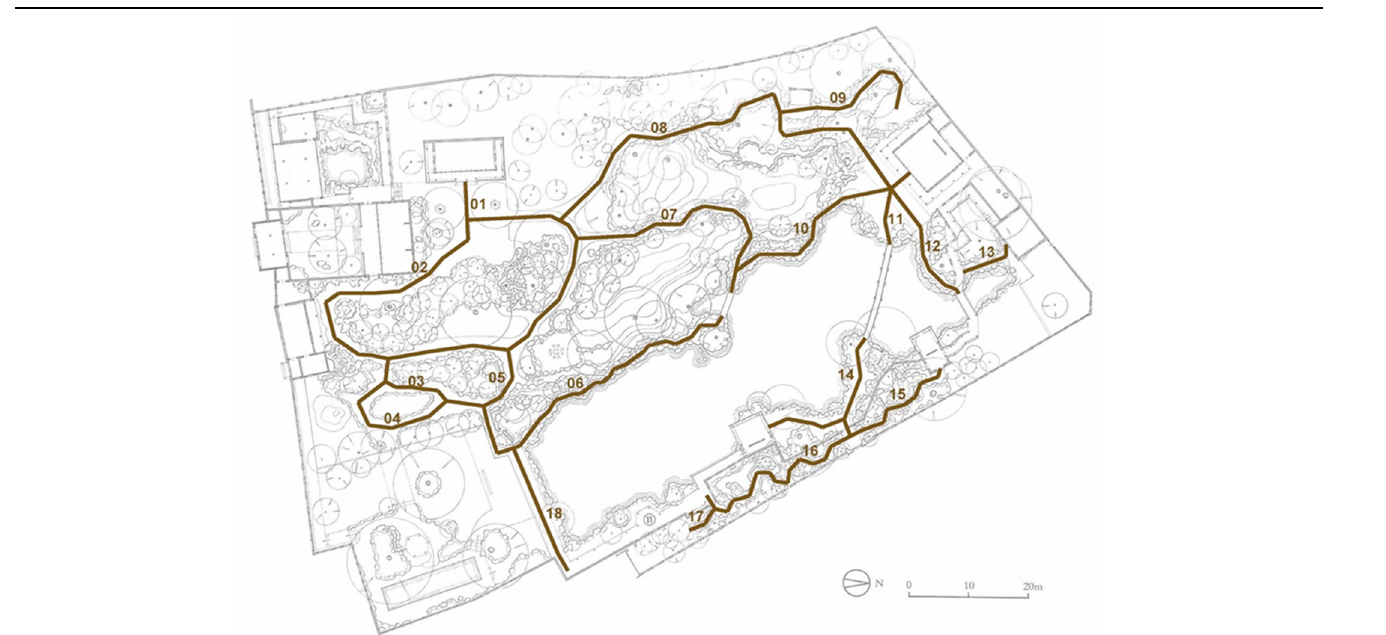
Table A10. Jichang Garden, garden path.